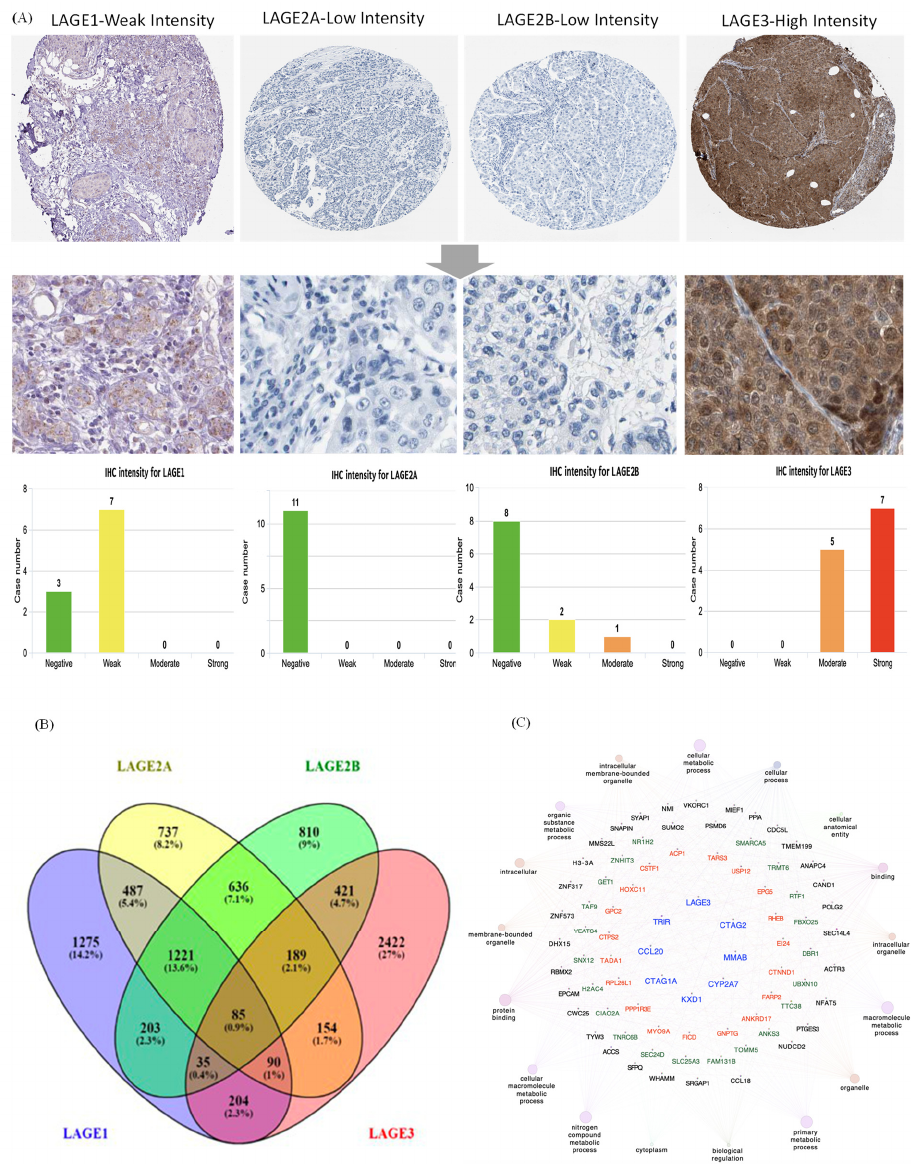
Figure 2. Expressions of L-antigen family genes throughout breast cancer tissues. ( A ) LAGE family genes, protein expressions in normal breast tissue, and breast cancer specimens from the Human Protein Atlas. Bar charts of the IHC staining intensity of LAGE family genes for breast cancer dictionary (10, 11, 11, 12 cases for LAGE1, LAGE2A, LAGE2B, LAGE3, respectively). ( B ) Venn diagram of LAGE family co-expression genes lists in TCGA breast cancer databases. The intersection of co-expression gene lists of each gene in the LAGE family. The approach was to select the top 20% of genes from the list of co-expressed genes extracted from the METABRIC dataset. ( C ) Through a Cytoscape analysis, thresholds were set to show pathways with p -value < 0.05, Network specificity as “Global”, Network Connectivity as “Medium”, and high correlations between LAGEs and metastasis markers were